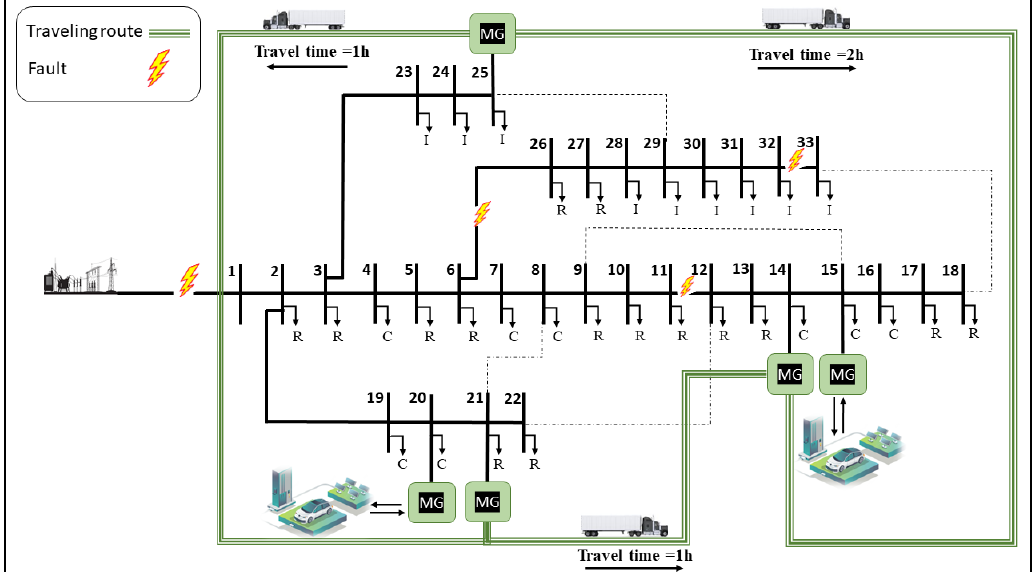
Figure 5. 33 ‐ Bus IEEE distribution system. Figure 5. 33-Bus IEEE distribution